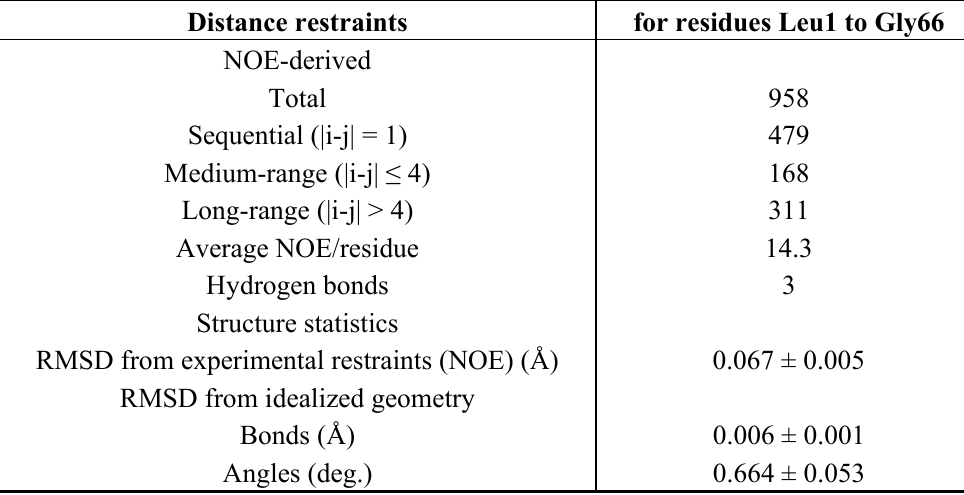
Table 1. Data for structure calculation and statistics for CV2